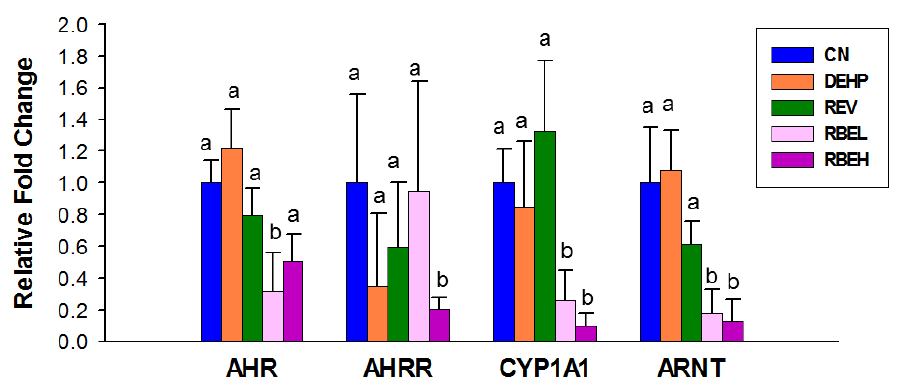
Figure 6. Effect of di-2-ethylhexylphthalate (DEHP), resveratrol (REV), and resveratrol butyrate ester (RBE) on the renal mRNA expression of the acryl hydrocarbon receptor (AHR) signaling pathway of male offspring at 12 weeks of age. AHRR= aryl hydrocarbon receptor repressor; CYP1A1 = cytochrome P450 CYP 1A1; ARNT = aryl hydrocarbon receptor nuclear translocator. The letters a and b indicate the differences between the groups ( p < 0.05, one-way ANOVA with post hoc Tukey’s test); CN = control; N =